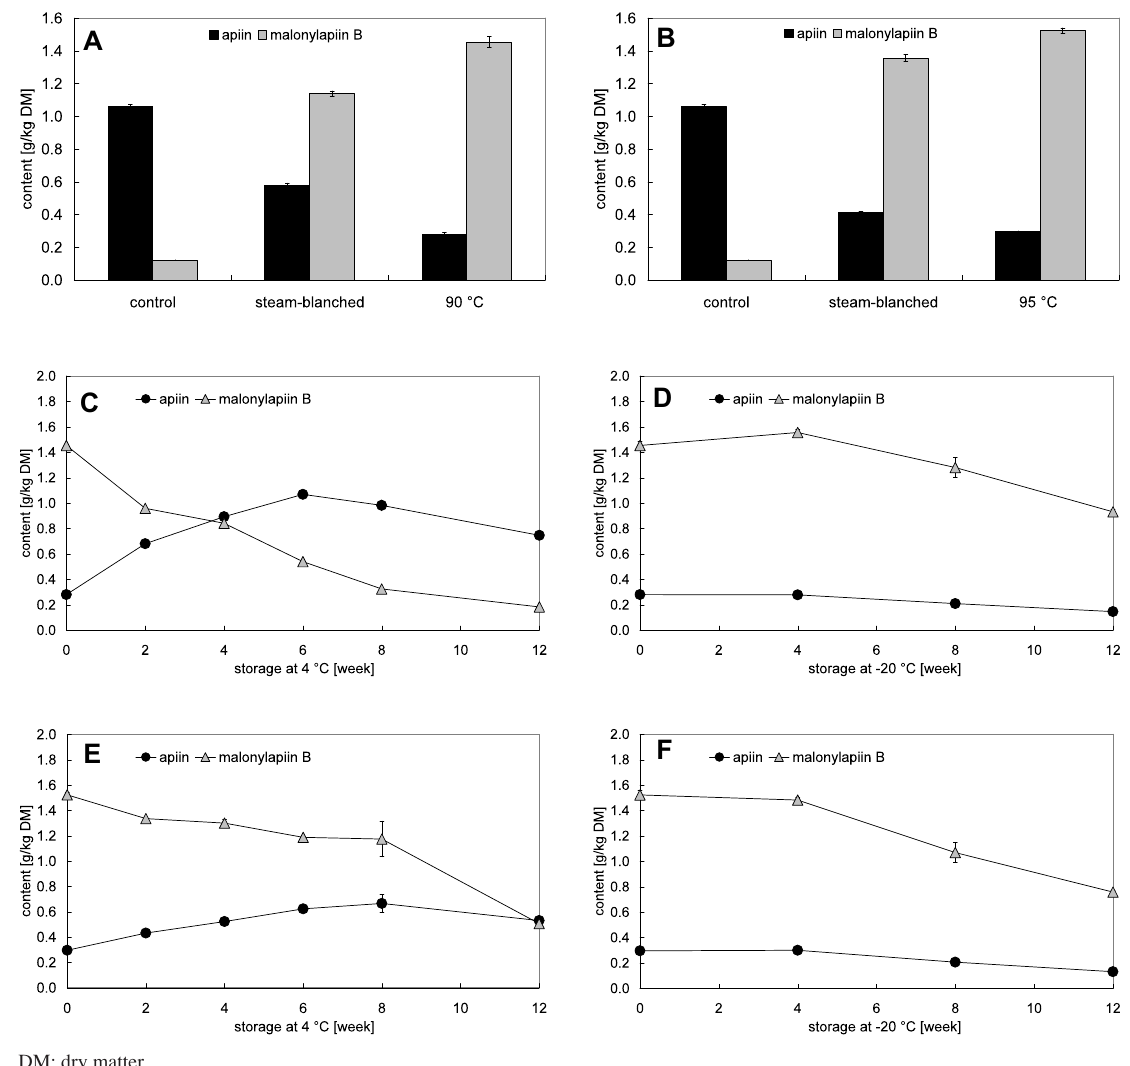
Fig. 3: Apiin and malonylapiin B contents during processing (A, B) and 12 weeks of storage (C-F) at 4 and -20 °C of celeriac pastes: (A) processing at 90 °C, (B) processing at 95 °C, (C) storage at 4 °C of the pastes processed at 90 °C, (D) storage at -20 °C of the pastes processed at 90 °C, (E) storage at 4 °C of the pastes processed at 95 °C, (F) storage at -20 °C of the pastes processed at 95 °C. Columns and bars represent mean ± standard deviation (n = 2).